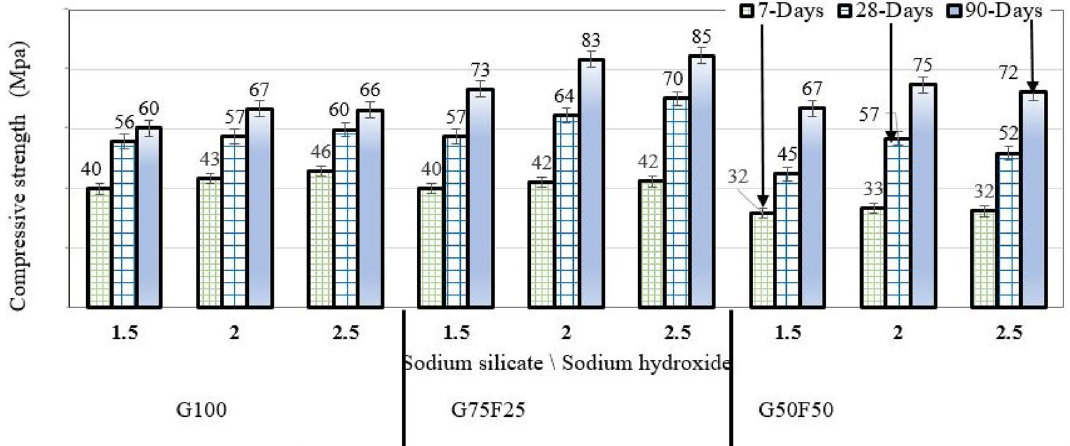
Figure 3. Compressive strength development of G100, G75F25, and G50F50 samples with Na 2 SiO 3 /NaOH ratios of 1.5, 2, and 2.5. Results where the average values of 10M, 12M, 14M, and 16M NaOH mixes.